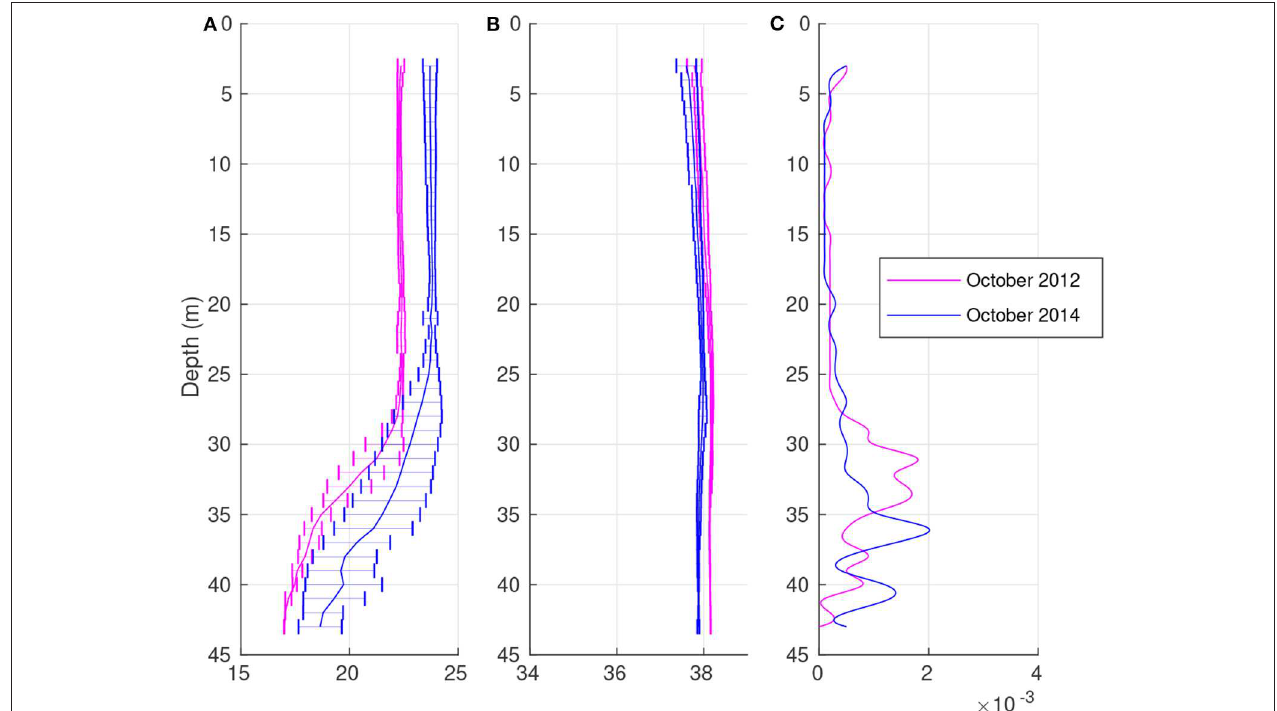
FIGURE 4 | Mean vertical profiles and standard deviations (bars) of temperature ( A ; ◦ C), salinity ( B ; g kg − 1 ), and the squared Brunt-Väisälä frequency [ C ; ( s − 2 )] in October 2012 (purple line) and October 2014 (blue line).